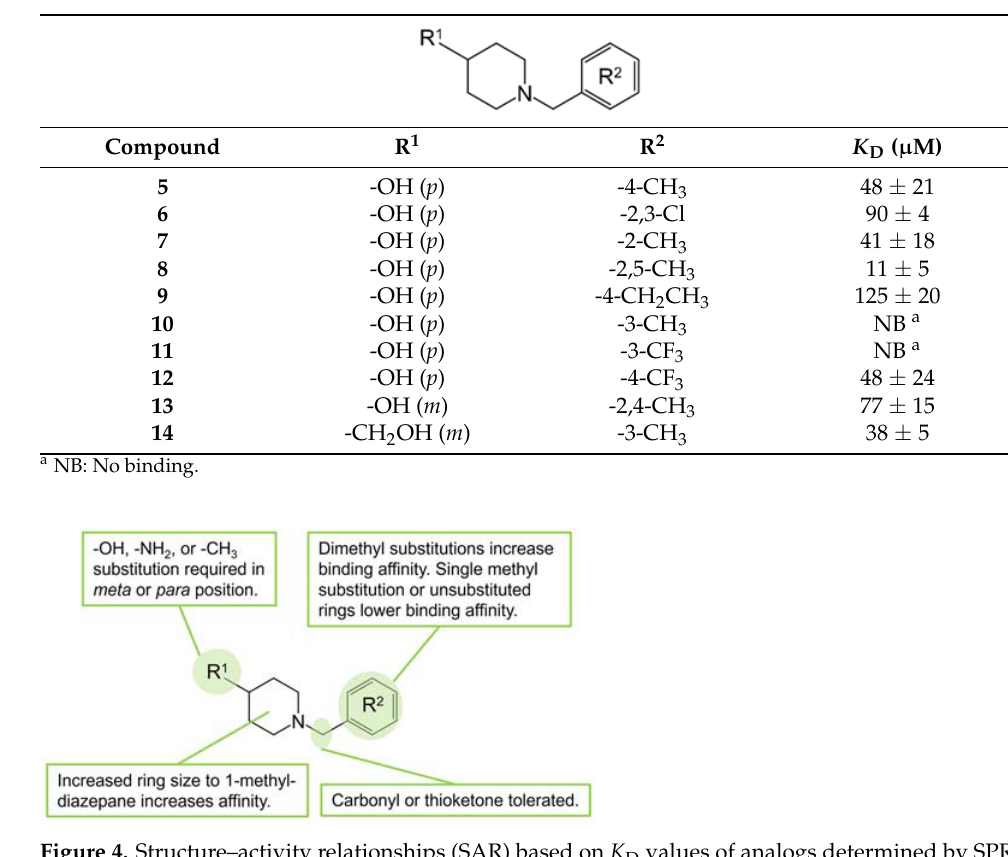
Table 1. K D Determination of additional analogs containing the main scaffold.